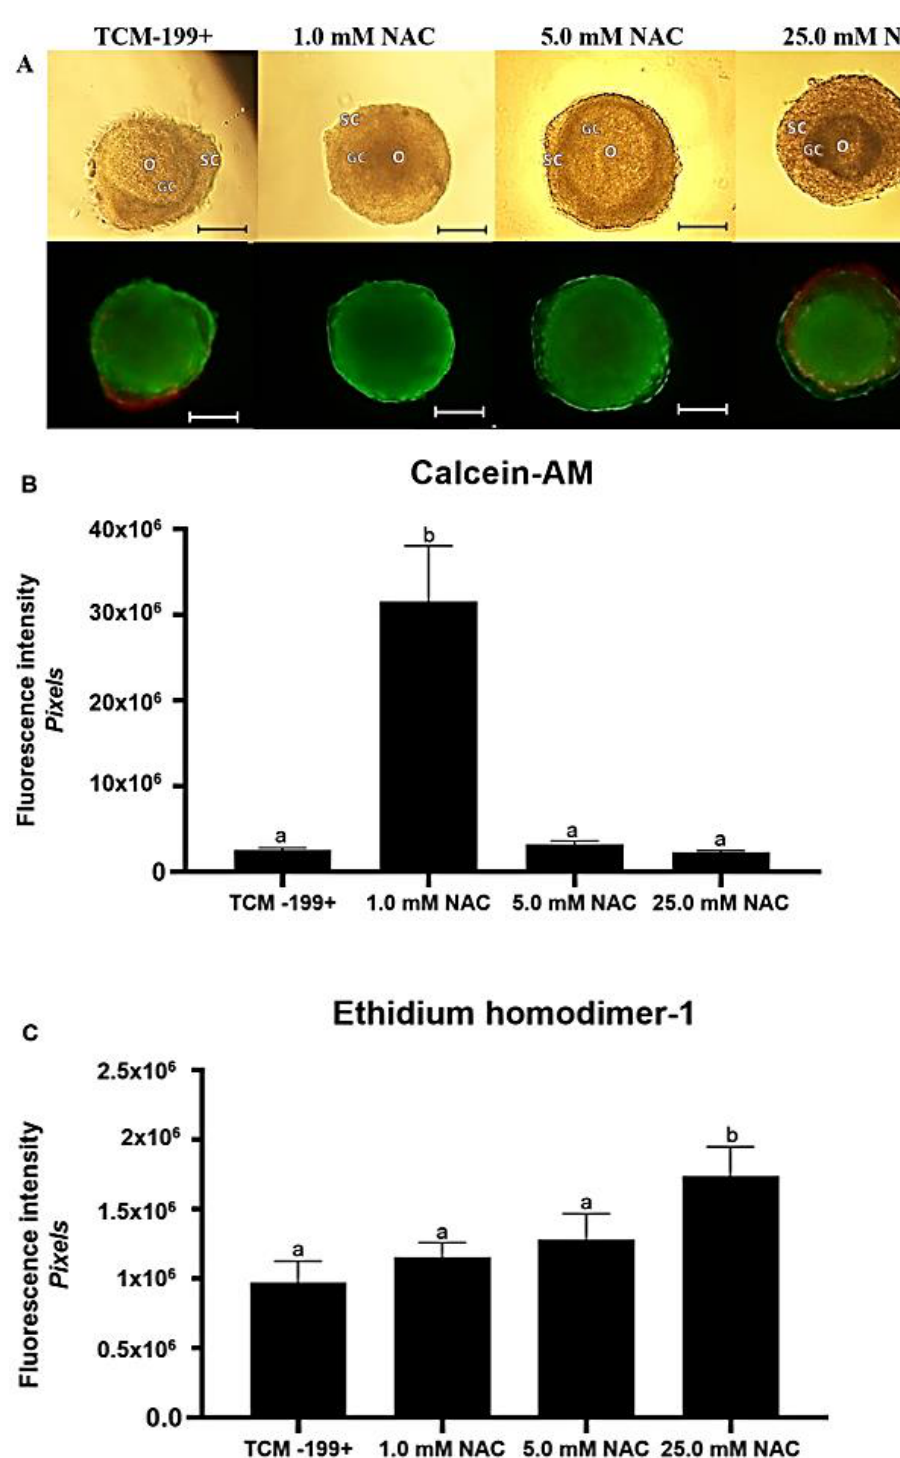
Figure 1. Morphology of secondary follicles after culturing in the different treatments ( A ). Staining intensity (mean ± SEM) for calcein-AM ( B ) and ethidium homodimer-1 ( C ) in bovine secondary follicles after 18 days of culturing in TCM-199 + alone or with different concentrations of NAC (1.0, 5.0, and 25.0 mM). Lower case letter “ a, b ” represent significant differences between treatments ( p < 0.05). O: oocyte, SC: stromal cells, GC: granulosa cells. Scale bar: 100 µm.